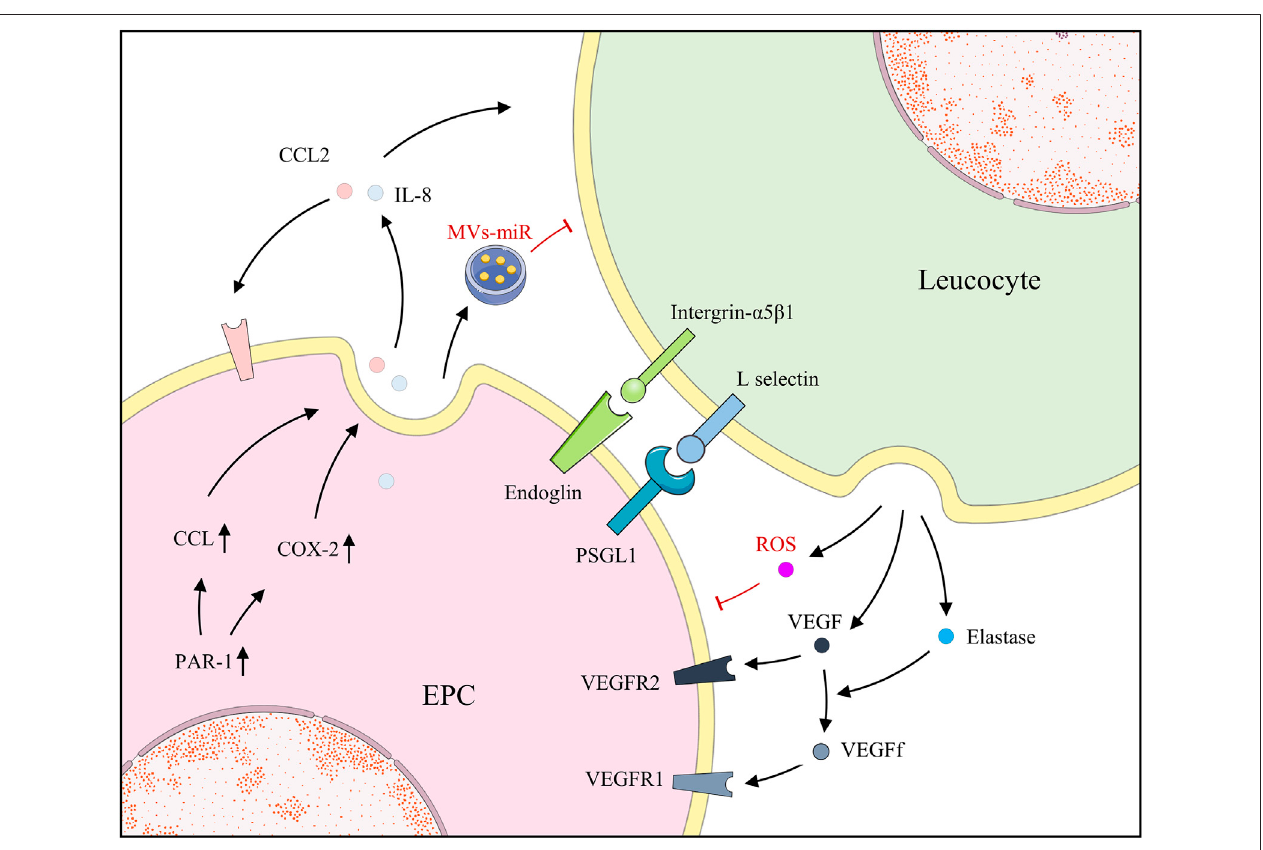
FIGURE 4 | EPCs and leucocytes positively regulate each other by secreting factors; however, EPCs and leucocytes also secrete MVs and ROS, respectively, for negative regulation.